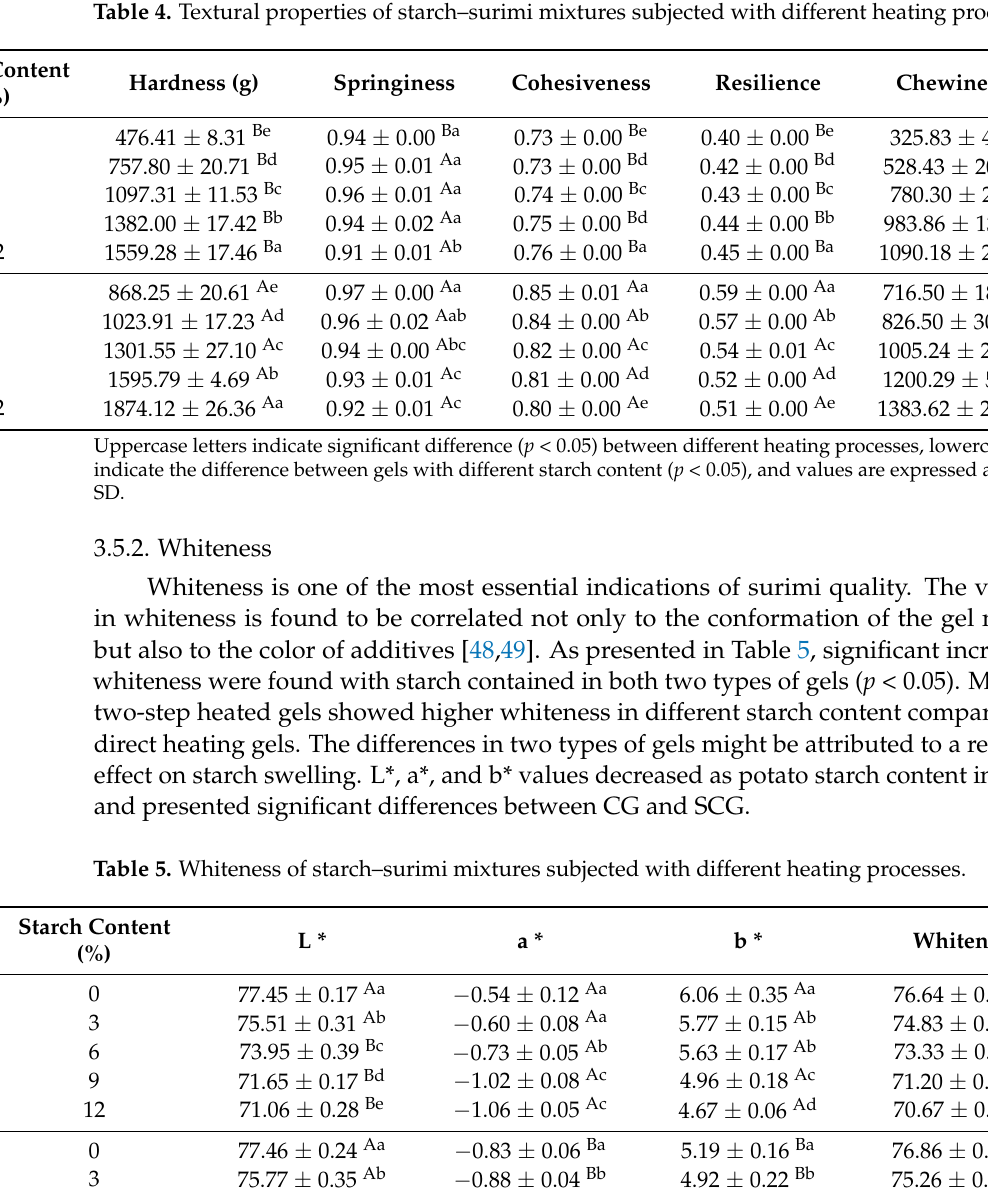
Table 4. Textural properties of starch–surimi mixtures subjected with different heating processes.